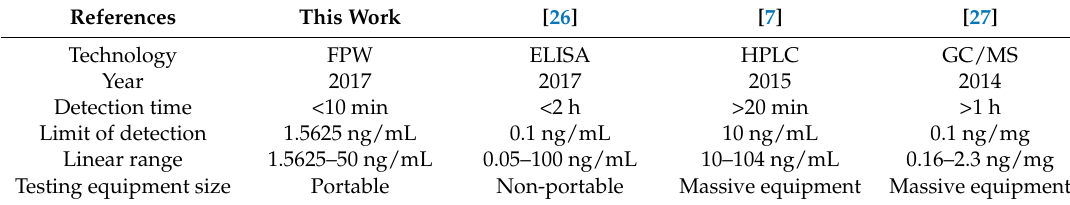
Table 2. Comparison of this research with the previous works of THC biosensor.